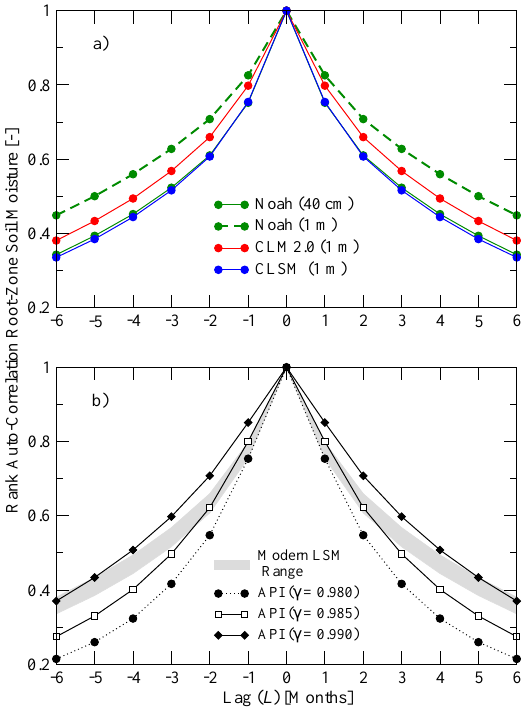
Fig. 2. Quasi-global land averages of ρ(L) for (a) modern LSMs (i.e., Noah, CLM2.0, and CLSM) and (b) various API cases. Noah results in (a) are shown for both a 40-cm and 1-m root-zone depth case. “Modern LSM Range” shading in (b) is defined as the absolute range of 40-cm Noah, 1-m CLM2.0, and 1-m CLSM ρ(L) results in part (a) .